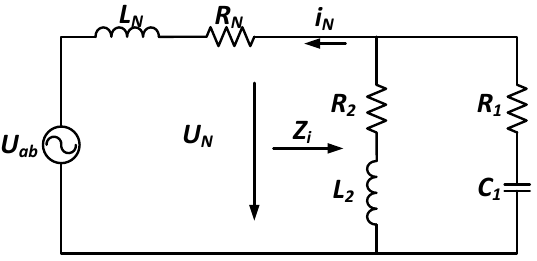
Figure 7. Equivalent parallel resonant circuit.